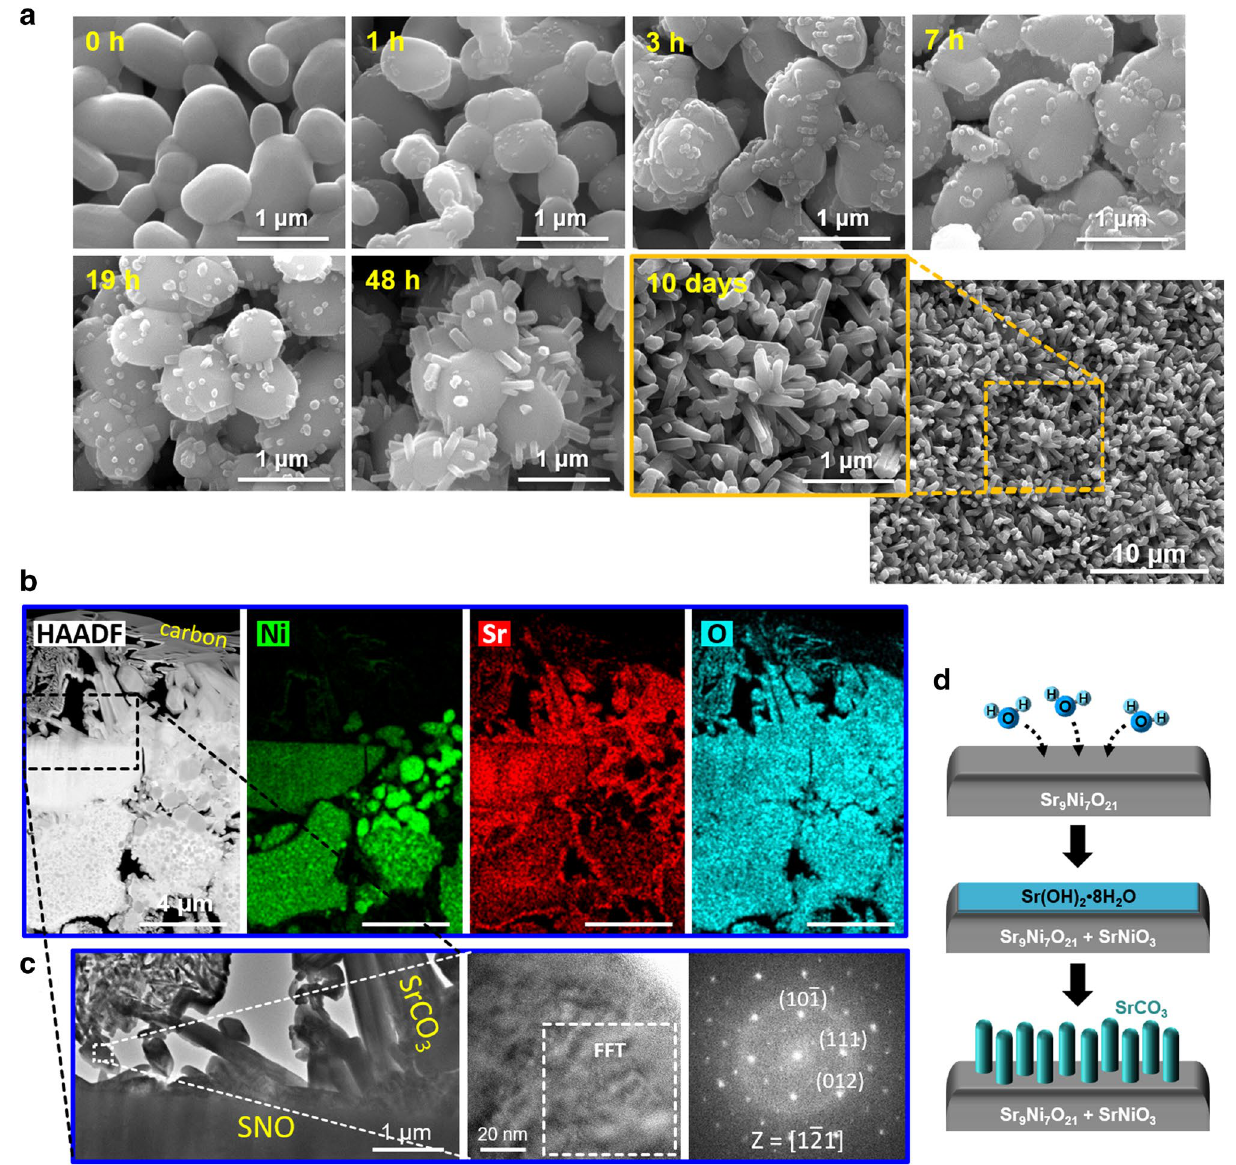
Figure 1. ( a ) SEM images of the surface of strontium nickel oxide pellet before and after the exposure to a humid environment (2.7% H 2 O content) for 1 h, 3 h, 7 h, 19 h, 48 h, and 10 days. The SEM–EDS spectrum of the nanorod array is also presented in Supplementary Fig. S2 online. It is noted that these samples were dried in ambient air (0.3% H 2 O content) for 2 h after exposure to the humid environment. SEM images of the samples that were not dried are also displayed in Supplementary Fig. S3 online. ( b ) High-angle annular dark-field (HAADF) and elemental mapping images (Ni, Sr, and O) of the cross-section of the SNO pellet exposed to the humid environment for 5 days, analyzed using FIB and STEM-EDS. ( c ) High-resolution TEM images of the nanorod grown on the SNO surface and the corresponding FFT pattern indexed in the Pmcn space group of SrCO 3 . ( d ) Schematic representation of the structural evolution of SNO by hydration and the accompanying SrCO 3 nanorod